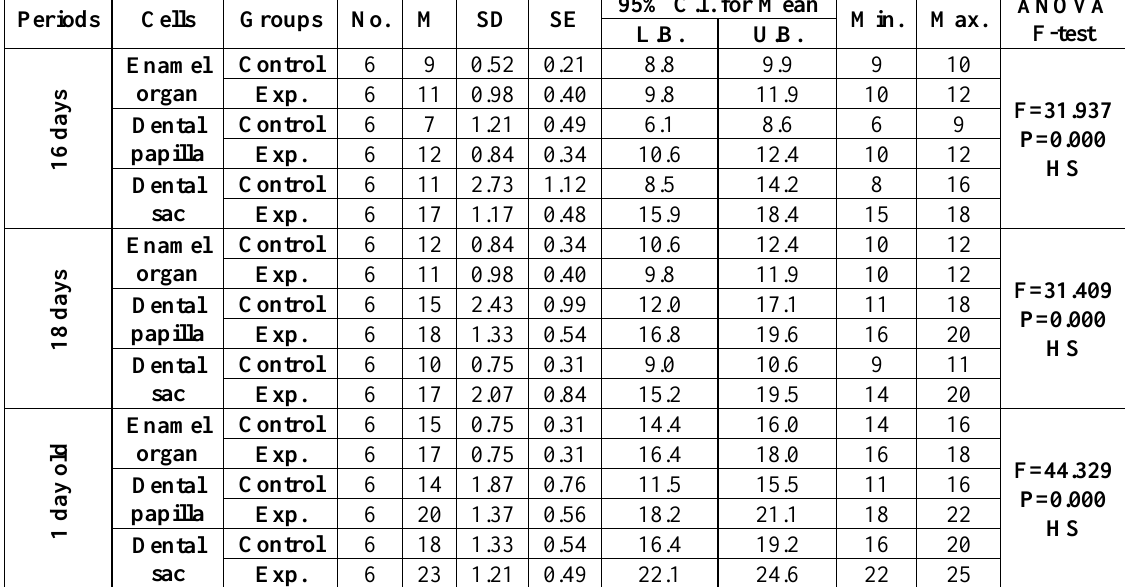
Table 1: Statistic analysis of different type of positive cells expressed TGF B1 in the studied groups distributed in each period with comparisons